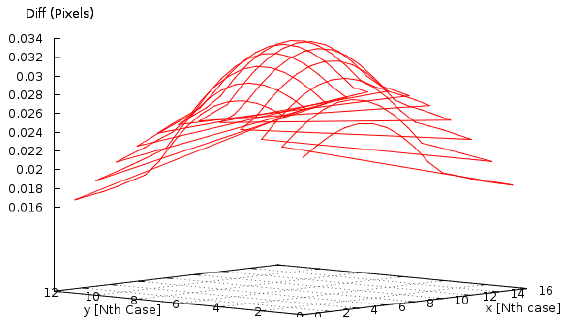
Figure 20. Maximum distance (in pixels) between the point pro- jected by the precise mapping and the point projected by the bi- linear function in each block of the grid of the image.